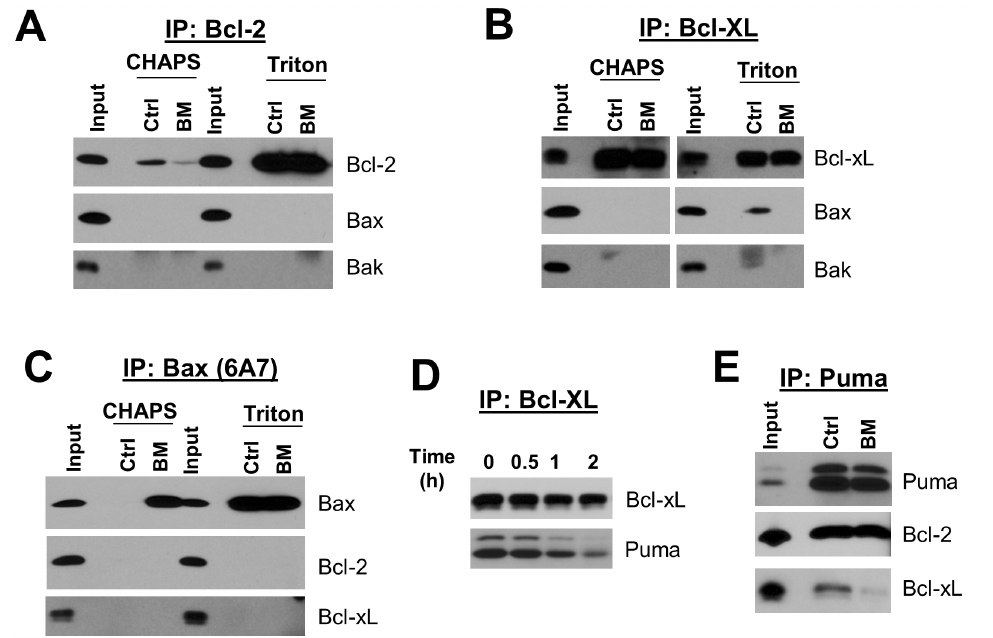
Figure 4. BM-1197 disrupts the association between BCL-XL and PUMA in MEF/ MCL1 2 / 2 cells. (A–C) MCL1 2 / 2 MEF cells were treated with DMSO (ctrl, control) or BM-1197 (BM, 50 nM) for 1 h and CHAPS- or Triton X-100-lysed whole cell extracts were immunoprecipitated with the indicated antibodies. The immunoprecipitates were analyzed by immunoblotting. (D & E) CHAPS lysed whole cell extracts from BM-1197 (50 nM)- treated MCL1 2 / 2 cells were immunoprecipitated with the indicated antibodies, and immunoprecipitates were analyzed for the presence of Bcl-xL and PUMA by immunoblotting.